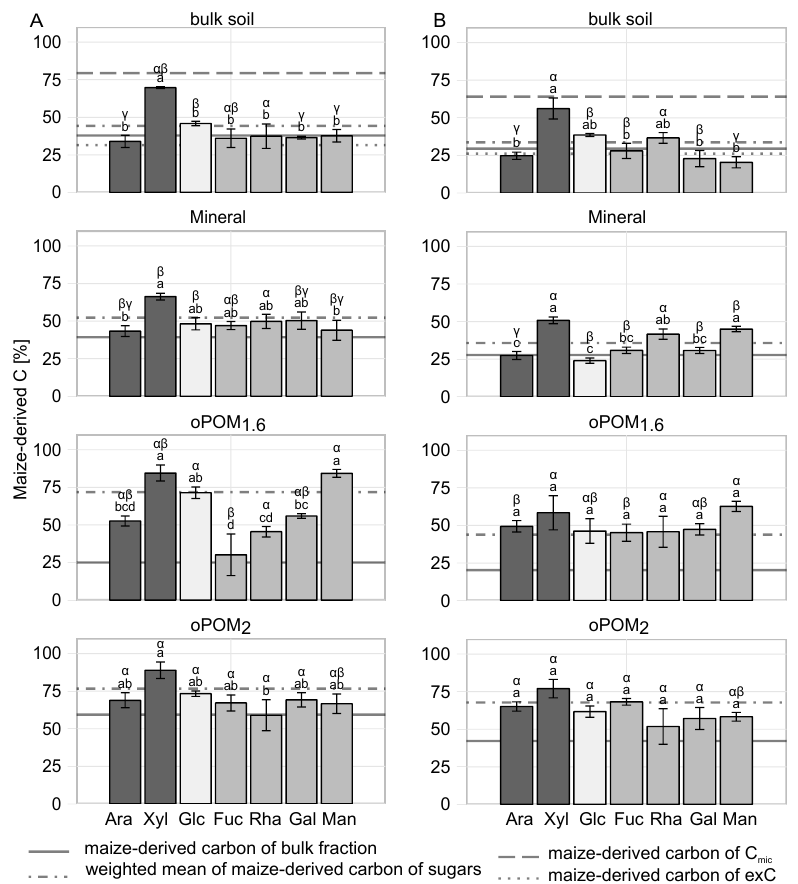
Figure 2. Maize contribution to sugars in bulk soil, mineral, oPOM 1 . 6 and oPOM 2 fractions in the (a) Ap (0–30cm) and (b) E-horizon (30– 45cm). Latin letters (a–d) indicate significant differences ( p <0.05) among the individual sugars within one fraction. Greek letters ( α − γ) indicate significant differences among different fractions for individual sugars. Means and standard error ( n =